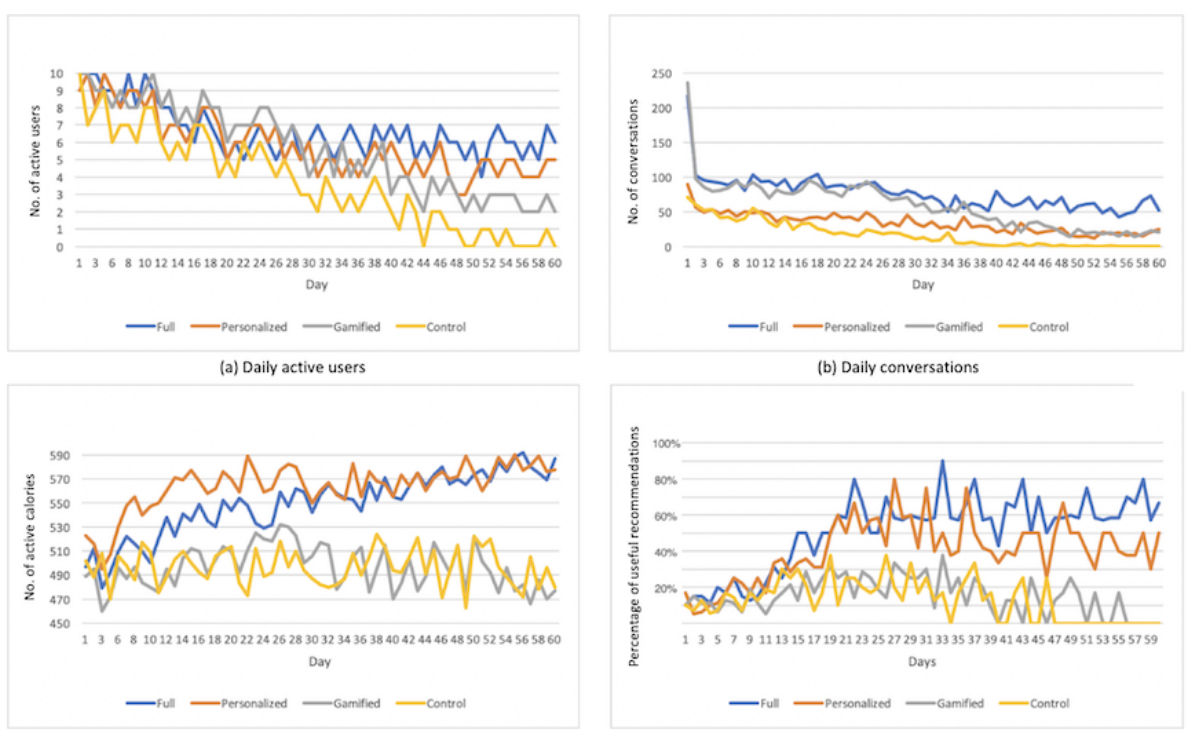
Figure 10. Daily statistical data showing patterns of daily active users, conversations, or active calories and percentage of useful recommendations along the